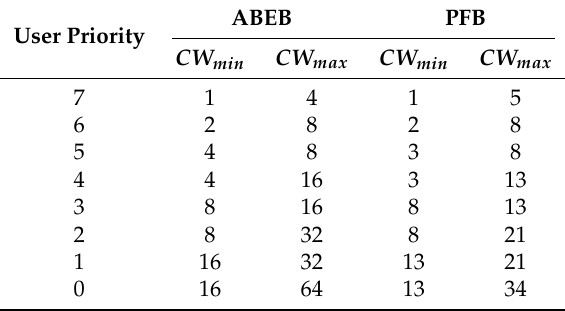
Table 2. CW bounds for ABEB and PFB procedures of IEEE 802.15.6